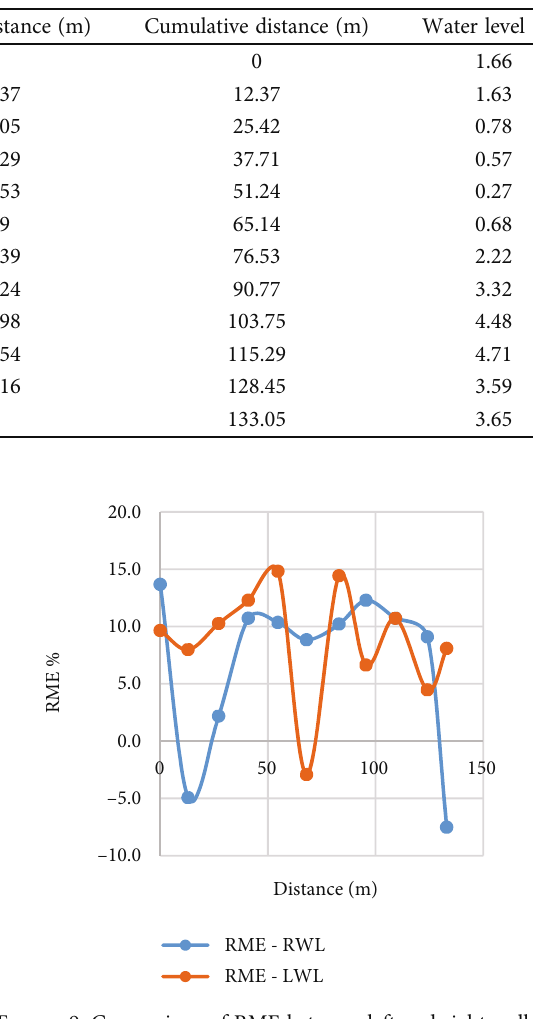
Table 8: Left water level-physical model.